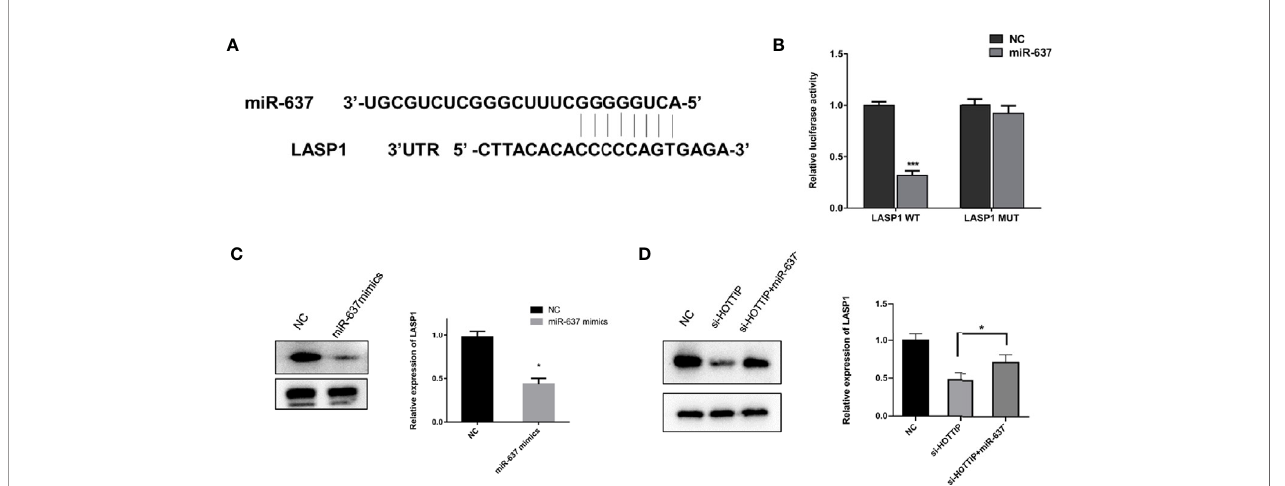
FIGURE 5 | miR-637 regulated LASP1 expression. (A) Predictive binding sites of lncRNA HOTTIP with miR-637. (B) Luciferase reporter gene assay of miR637 and LASP1. (C) Western blot analysis of LASP1 expression under the in fl uence of miR-637 overexpression in QBC939 cells. (D) Western blot analysis of LASP1 expression with HOTTIP inhibition and rescue of miR-637 inhibition. (*p < 0.05, ***p <